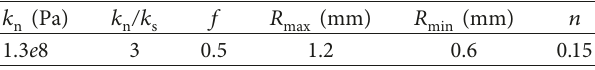
Table 3: Microscopic parameters of samples at the final state.